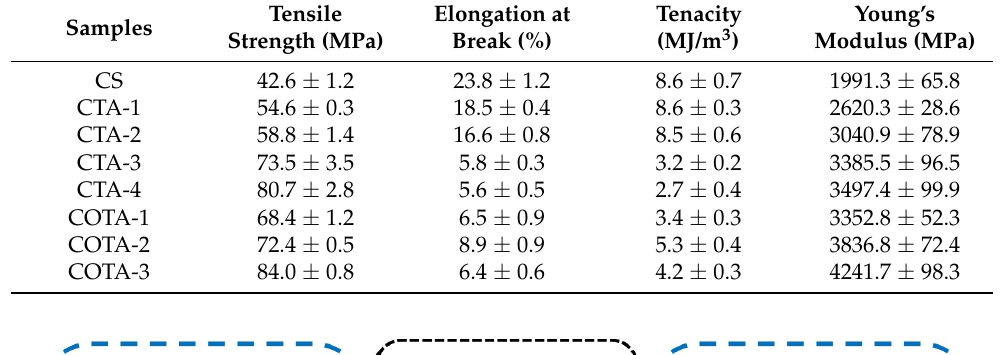
Figure 8. ( a ) Stress–strain curves for CS and CTA films; ( b ) stress–strain curves for CS and COTA films.